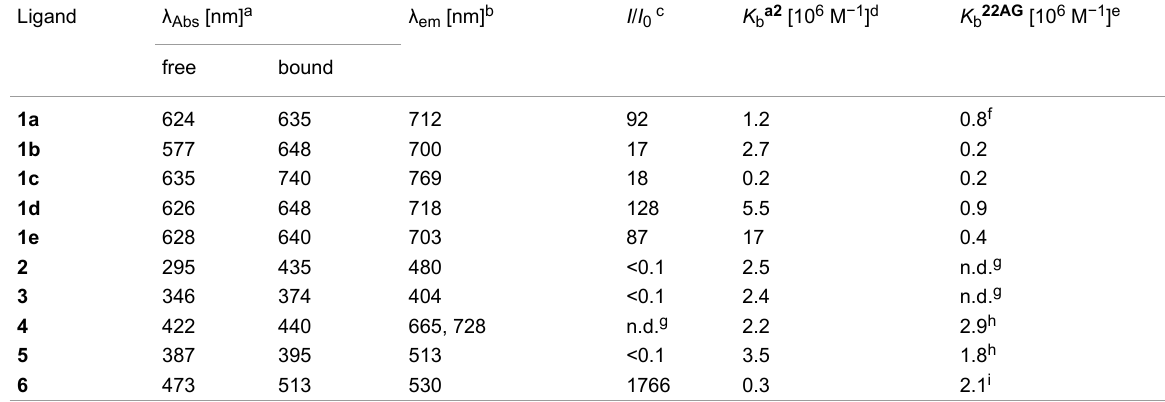
Table 2: Absorption and emission properties of ligands 1 – 6 in the absence and presence of ILPR-DNA a2 , and binding constants K b . Ligand